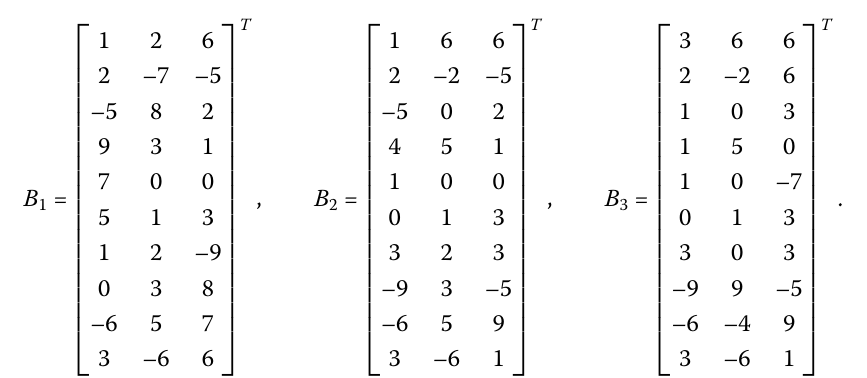
Figure 3 Errors for Example